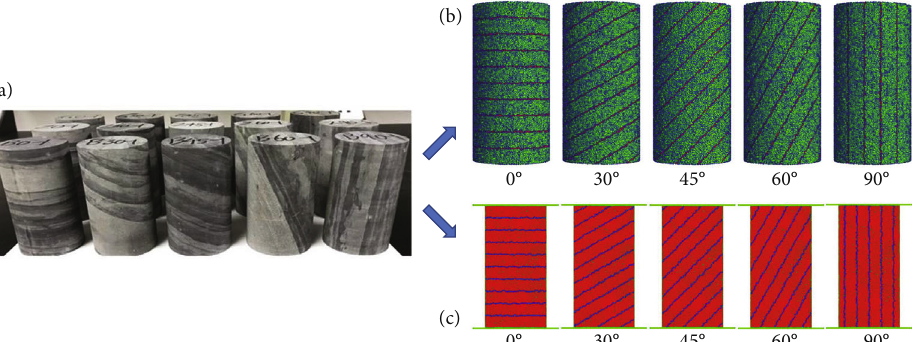
Figure 17: Schematic diagram of sample and particle model under uniaxial compression. (a) Test specimen, (b) three-dimensional particle model, (c) two-dimensional particle